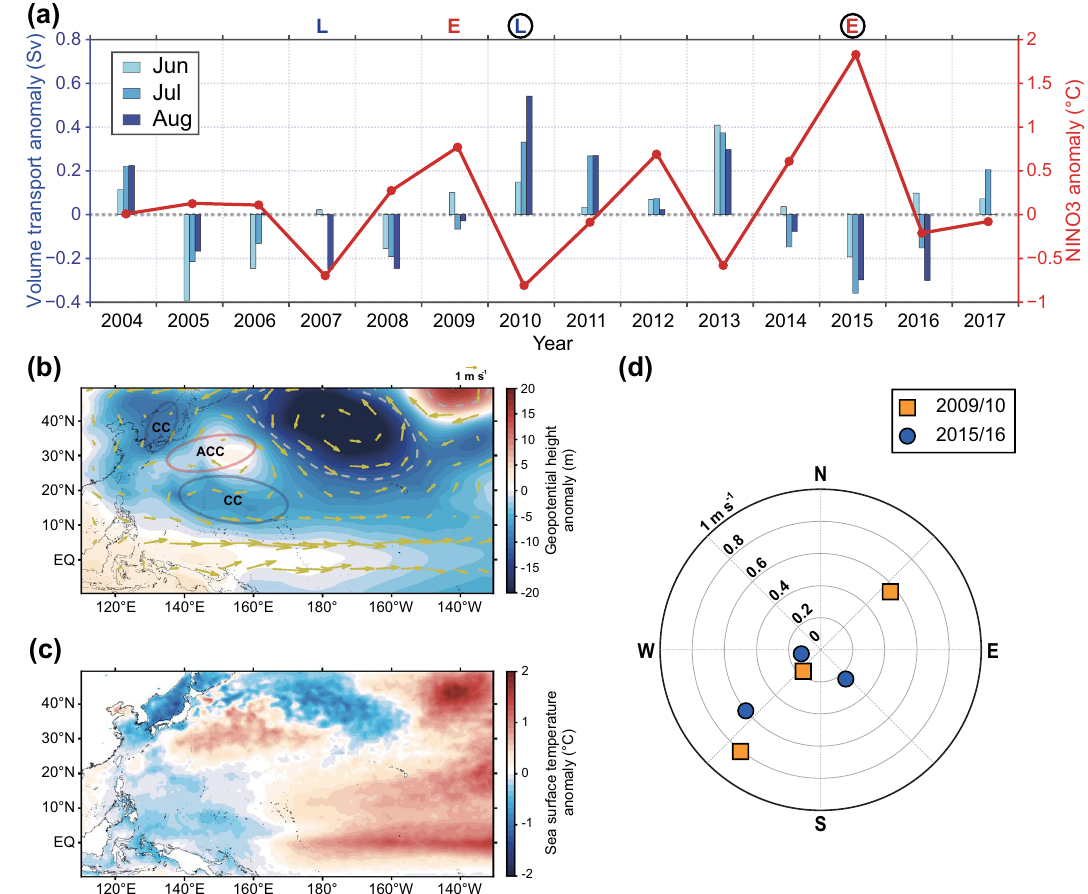
Figure 2. | Remote impact of NINO3 on volume transport through external climatic factors in summer (JJA). ( a ) Volume transport anomaly (blue bars) and averaged NINO3 anomaly (red line) for summer. E and L on top of ( a ) indicate the developing years of El Niño and La Niña events, respectively. Surrounding black circles mean that summer NINO3 and PDO are in phase. ( b ) Composite maps of the averaged anomalies of wind velocities and geopotential height at 850 hPa during the developing summer of El Niño years (2009/10 and 2015/16). CC indicates a cyclonic circulation, and ACC indicates an anti-cyclonic circulation. Gray dashed lines denote statistical significance at the 90% confidence level. ( c ) Composite maps of the averaged anomalies of sea surface temperature during the developing summer of El Niño years (2009/10 and 2015/16). ( d ) Wind velocity anomalies over the Korea/Tsushima Strait during the developing summer of El Niño years. The figure was created using MATLAB (ver. 9.9.0.1592791 (R2020b) Update 5). The coastline is based on the ETOPO1 dataset (https:// www. ngdc. noaa.